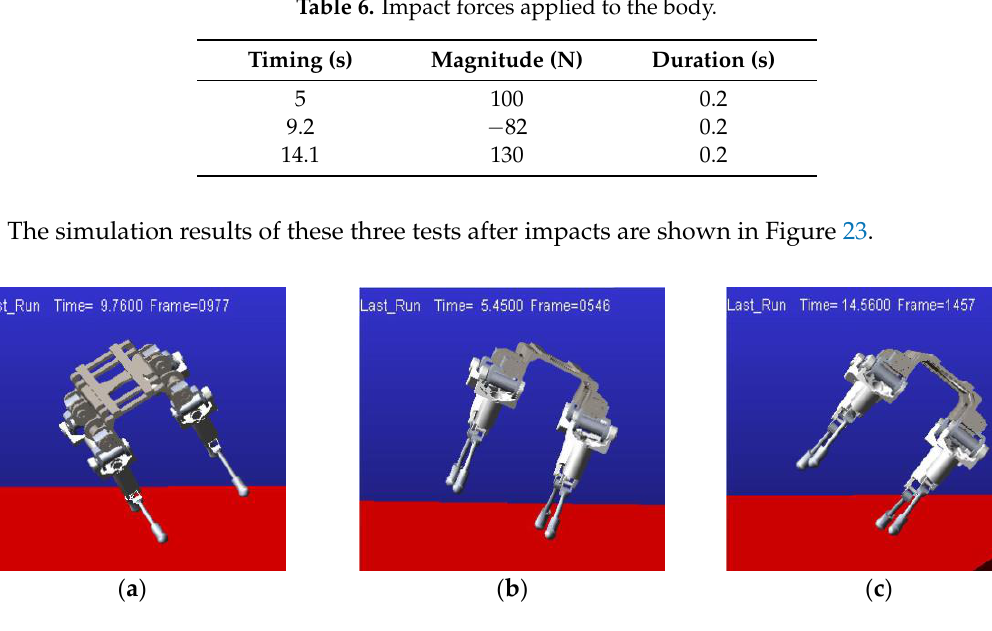
Figure 23. Tumbling moments of the three tests: ( a ) Test 1: 9.76 s; ( b ) Test 2: 5.45 s; and ( c ) Test 3: 14.56 s.